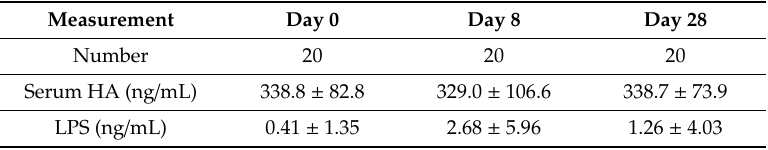
Table 6. Serum measures of LPS and hyaluronan